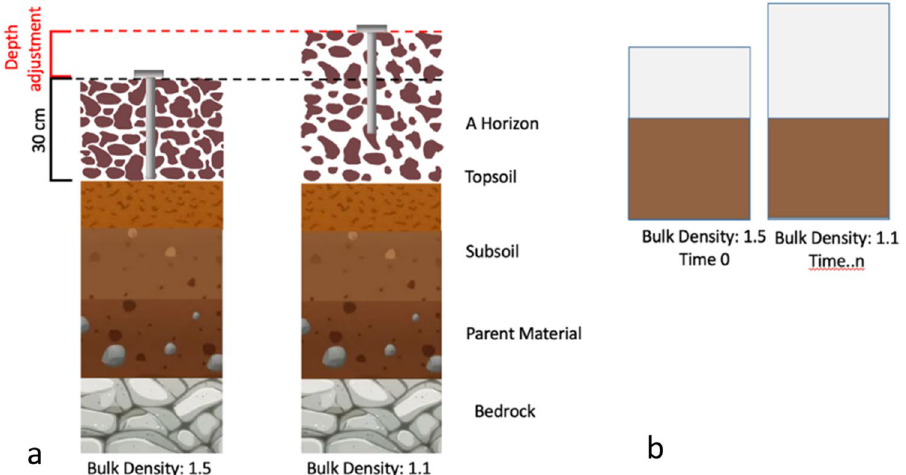
Figure 1. ( a ) Example of pedon alteration due to changes in bulk density over time showing the position of the soil sampling device from the soil surface to the same fixed depth. ( b ) Example of pedon after the correction showing the difference in air space, while the soil mass remains